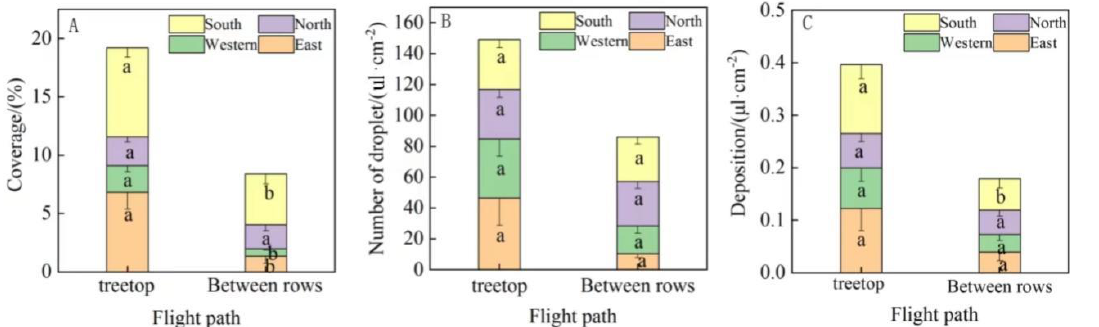
Figure 6. Comparison of different UAV flight routes and the effect on mist droplets in four directions of the ‘Kuerle Xiangli’ canopy: ( A ). comparison of different UAV flight routes and the droplet coverage in four directions of the ‘Kuerle Xiangli’ canopy, ( B ). comparison of different UAV flight routes and the droplet density in four directions of the ‘Kuerle Xiangli’ canopy, ( C ). comparison of different UAV flight routes and the amount of droplet deposition in four directions of the ‘Kuerle Xiangli’ canopy. Different lowercase letters indicate significant difference in the same direction among different treatments ( p < 0.05 ).